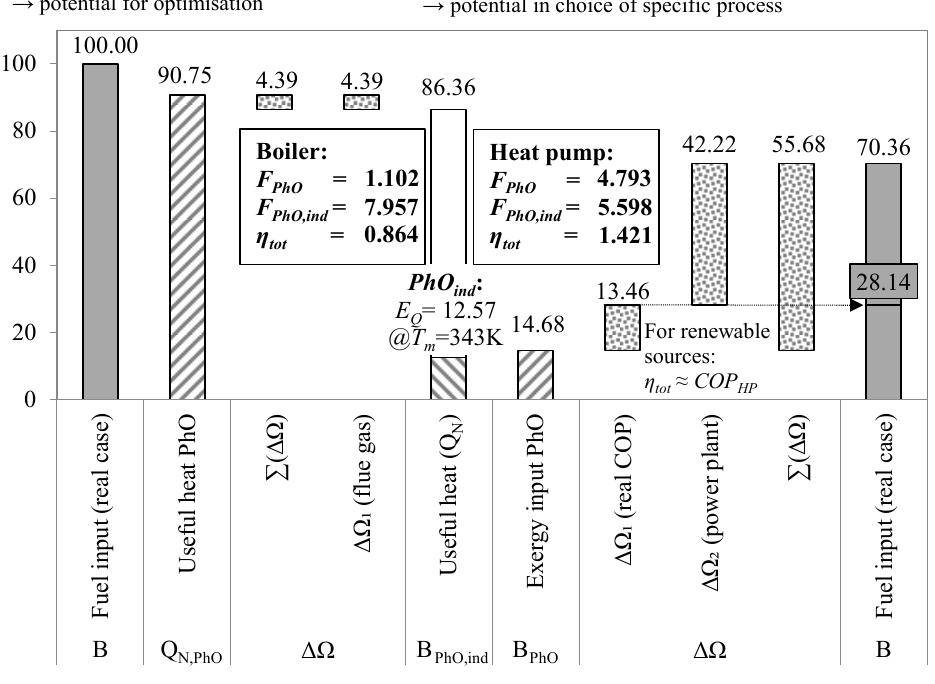
Figure 8. Cascade of losses—comparison of heat supply for boiler and HP.